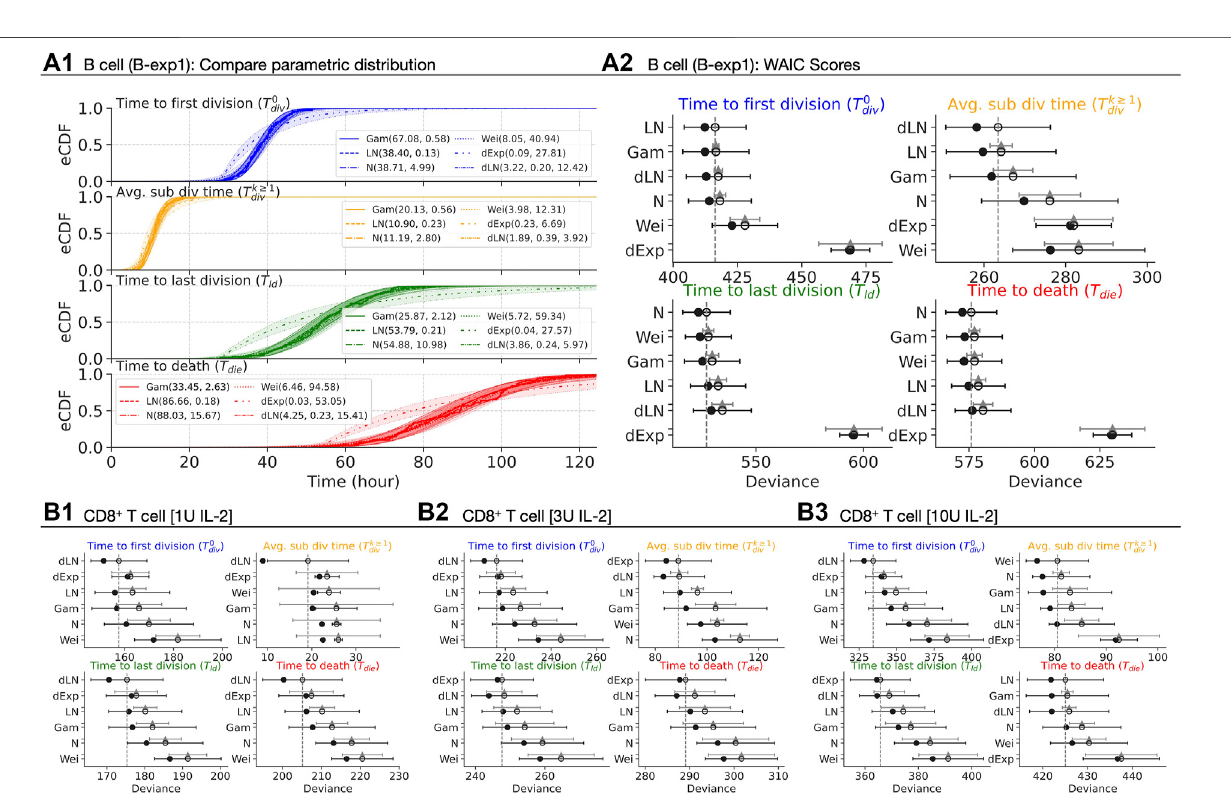
FIGURE 4 | Best parametric distribution class. (A1) Empirical CDF of the measured times are overlaid with CDFs of Gamma, Lognormal, Normal, Weibull, delayed Exponential and delayed Lognormal distributions. 95% con fi dence bands are plotted by randomly drawing 10 4 samples from respective posterior distributions. (A2, B1 – B3) The in-sample deviance (dot), and WAIC scores (open-circle) with 1 standard deviation error bar are shown. The y -axis is sorted from lowest (top) to highest (bottom) WAIC score. The lower WAIC score indicates better descriptor of the data. Except the top-ranked one, the value of the difference of WAIC (grey triangle) between a candidate and the top-ranked are shown with 1 standard error of the